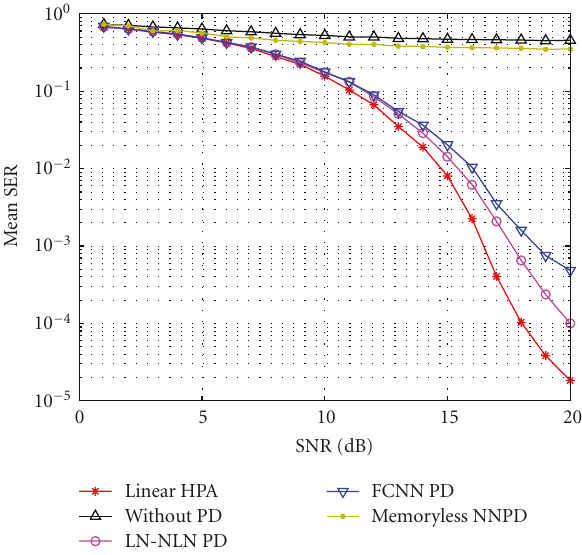
Figure 24: SER performance for 16-QAM OFDM with 64 carriers at IBO =